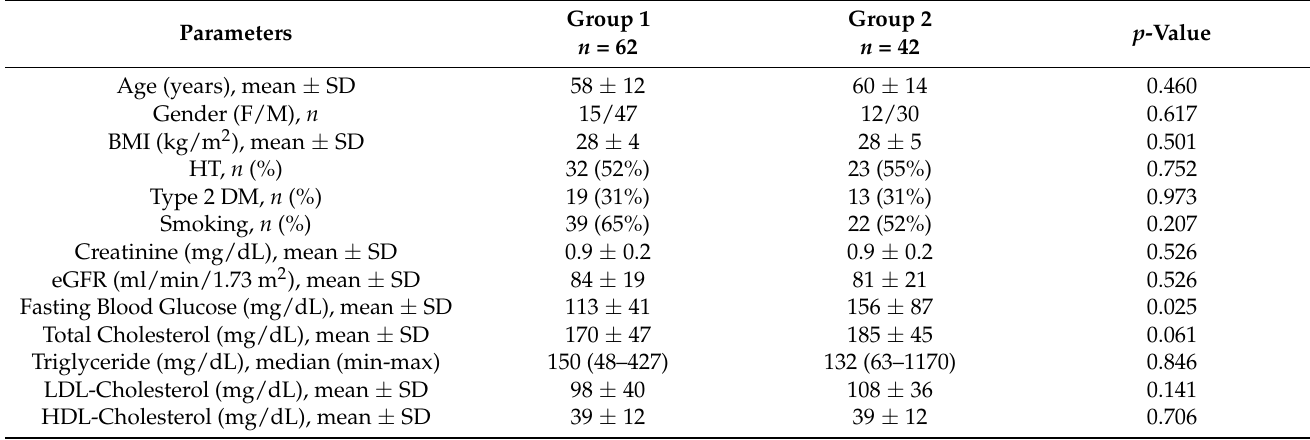
Table 1. Basic Demographics, Clinical Characteristics, and Laboratory Measurements of the Patients Included in the Study.